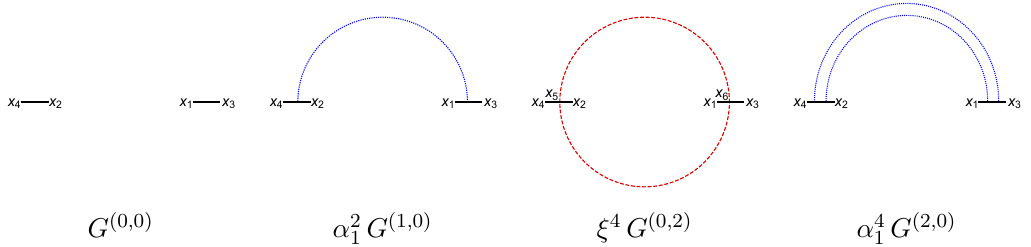
Figure 16 . Feynman diagrams de(cid:12)ning the (cid:12)rst few terms of the weak-coupling expansion of G 0 . G ( n;k ) stands for diagram with k single-trace vertices and n double-trace vertices. Dashed blue line denotes delta-function, black and dashed red lines denote free scalar